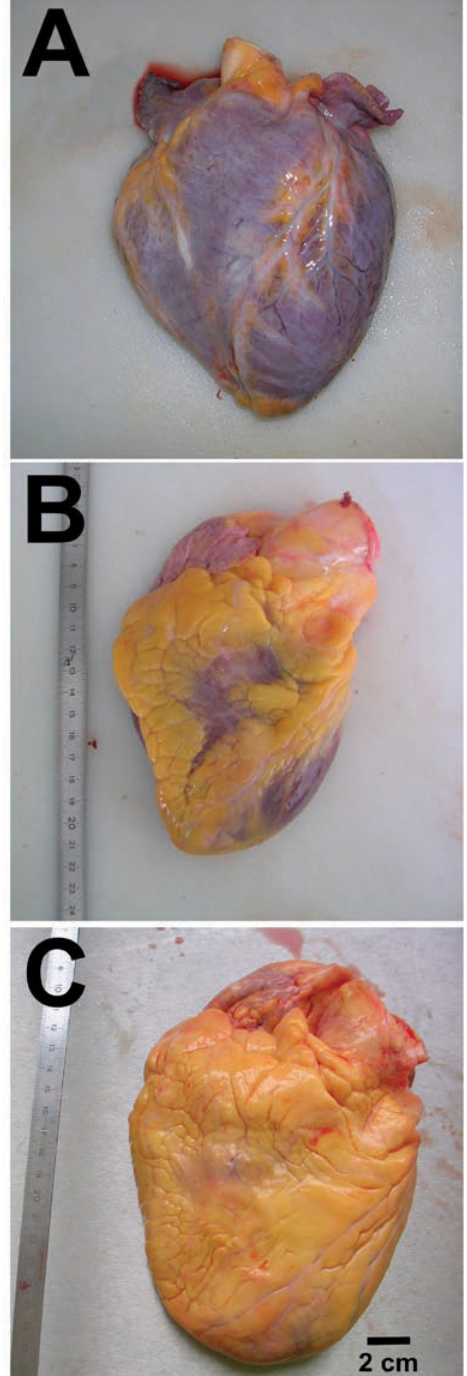
Figure 1. Images of excised hearts of human adults showing wide variability in the epicardial adipose tissue: (A) small quantity of EAT along the branches of the coronary arteries, (B) EAT depots extend over the anterior surface of the ventricles, (C) EAT massive depot including all the anterior surface of the heart. Bar = 2